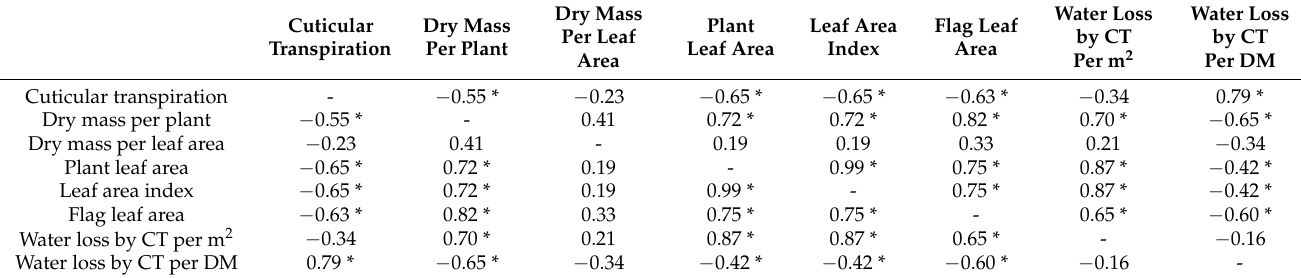
Table 3. Correlation matrix of analyzed leaf, growth, and water loss traits in wheat and Aegilops genotypes ##